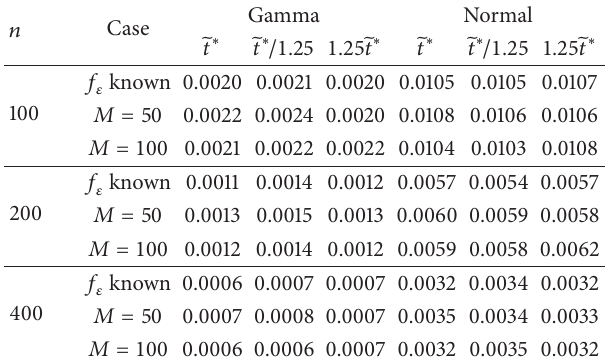
Table 3: MISE for the self-consistent estimator with different values of ̃𝑡 when the error distribution is double exponential.